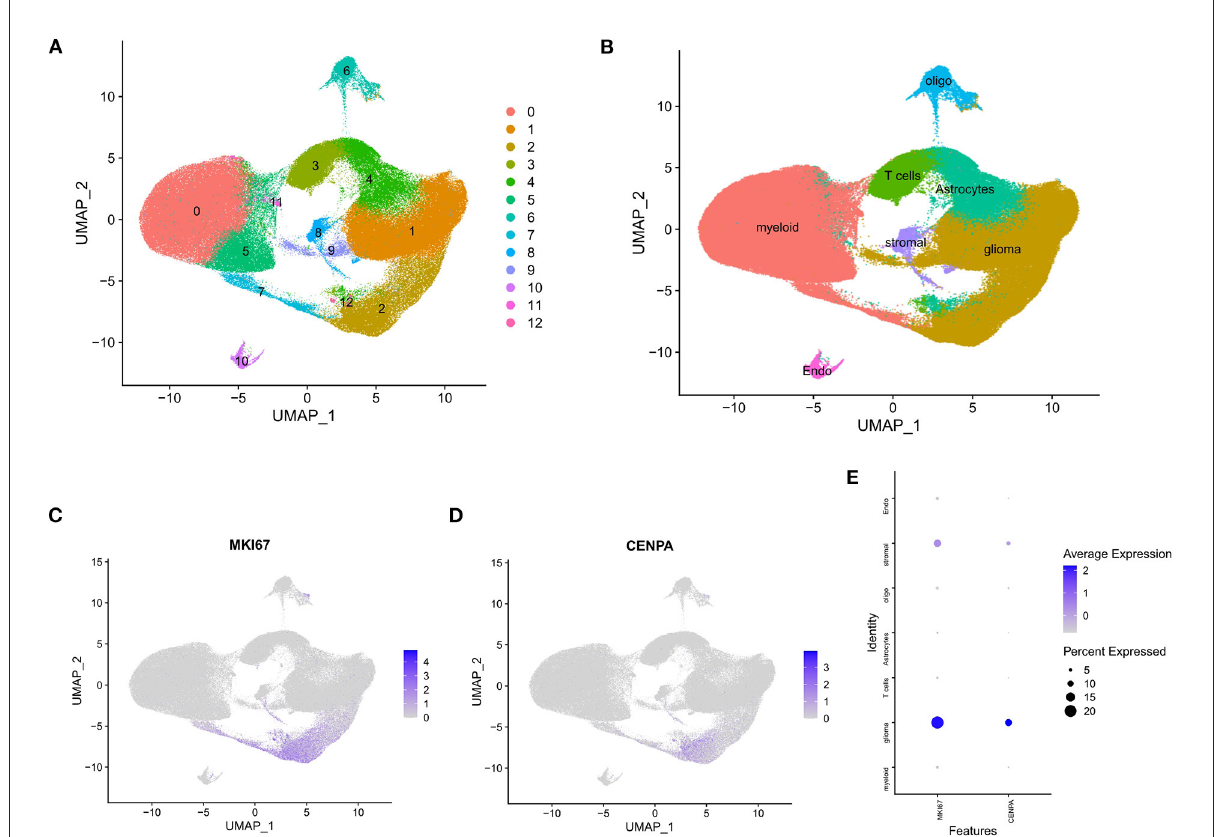
FIGURE9 Single-cell analysis of single-cell mRNA sequence. (A) Two-dimensional UMP plot depicted that 250,944 single cells were divided into 13 clusters and displayed in different colors. (B) The 13 clusters were annotated as seven types of cells: glioma, oligodendrocytes, astrocytes, myeloid cells, T cells, stromal cells, and endothelial cells. (C) MKI67 expression in each cell. (D) CENPA expression in each cell. (E) Bubble plot showed the expression of MKI67 and CENPA in different types of